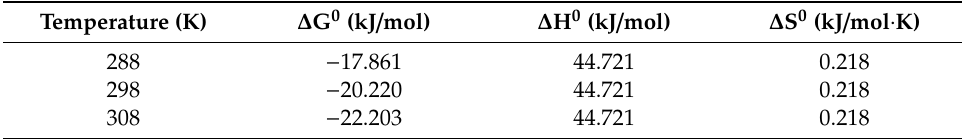
Table 2. Thermodynamic parameters of phosphorus adsorption.